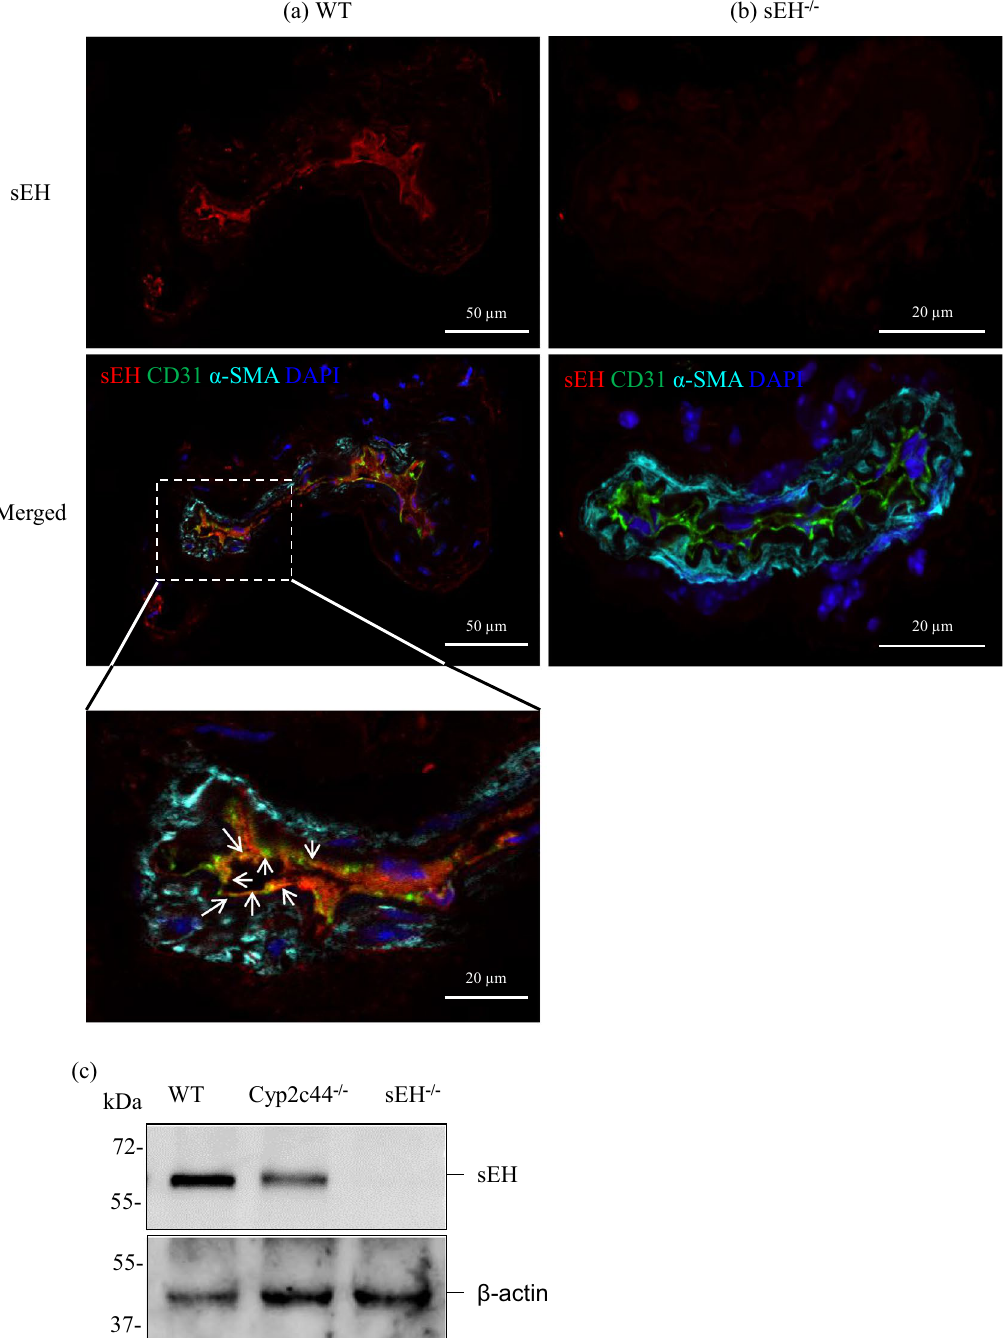
Figure 2. Expression and localization of sEH in the mouse ophthalmic artery. Immunofluorescence staining of representative ophthalmic artery sections demonstrated the expression of anti-sEH antibody (in red) in the ( a ) WT tissue and absence of its immunoreactivity in the ( b ) sEH −/− artery, which served as a negative control. Endothelial cells were stained green with CD31, α-SMA in cyan and nuclei were stained blue with DAPI. The magnified section of the artery shows the localization of sEH in the endothelial cells, as indicated by arrows. ( c ) Representative blot of sEH expression in the artery samples demonstrated the expression of this protein in the WT artery compared to null expression in the sEH −/− artery. The sEH protein level was normalized to β-actin. Scale bars indicate 50 µm and 20 µm for lower and higher power magnification, respectively. Samples were pooled from n = 5 mice/ WT and n = 6 mice/ Cyp2c44 −/− and sEH −/− each, per Western blot analysis. The sEH and β-actin bands were cropped from full gels (Supplementary Fig. S1